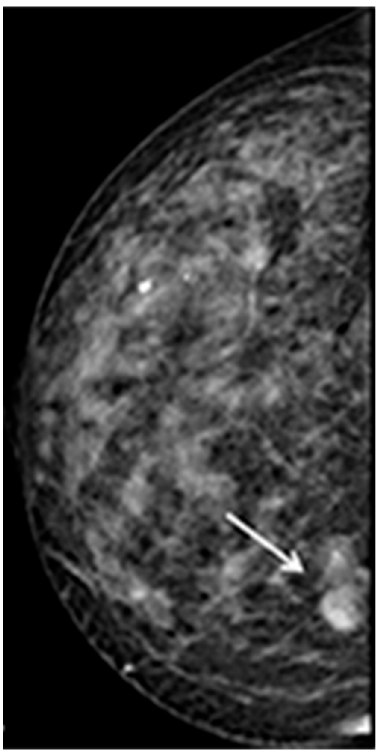
Figure 2. Digital cranio-caudal mammographic view: the lesion appears as a round opacity with regular edges located in the lower inner quadrant of the right breast (arrow).